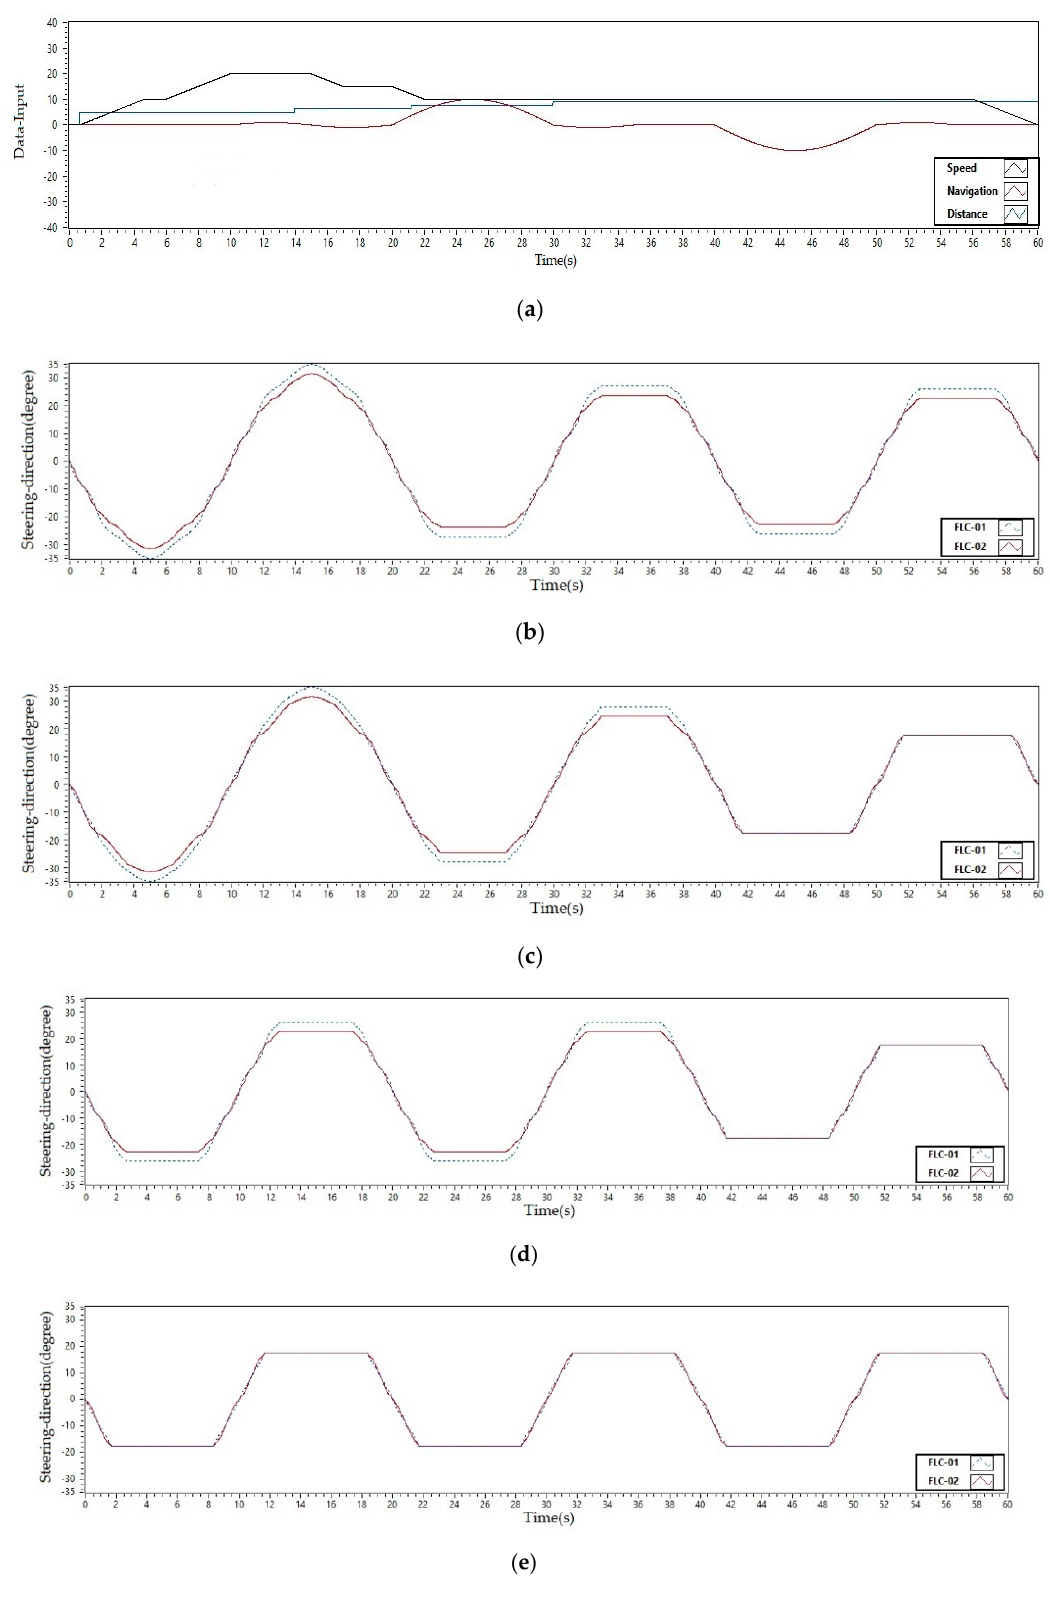
Figure 6. ( a ) Input of system; ( b ) system output at speed 10 km/h; ( c ) system output at speed 20 km/h; ( d ) system output at speed 30 km/h; and ( e ) system output at speed 40 km/h. According to the previous description and Figure 6d, the steering angle control value at 30 speeds for short and medium distances was similar. Type-1 FLC had an angle of 26.25 degrees, while type-2 FLC was at 22.750 degrees. The steering angle of type-2 FLC was smaller than that of type-1 FLC. This indicates that type-2 FLC had better control at high speeds. Furthermore, the shape of the graphic response was also smoother. Mean- while, with a long-distance input of 10 meters, both showed the same steering angle re- sults. At a high speed (according to city car specifications) of 40 km/h and at a distance of 3.5 meters, both type-1 and type-2 FLC achieved a maximum steering angle of –17.5 de- grees in 1.68 seconds to 8.32 seconds. The direction shown was to the left because it was negative. Meanwhile, at 11.68 seconds to 18.32 seconds, the steering angle showed a value of 17.5 degrees in positive numbers, indicating the right direction. The same thing happened when the obstacle distance was increased to seven meters. Both the right and left steering directions still showed a value of 17.5 degrees in response to the sinusoidal navigation input. The steering angle of the autonomous vehicle remained at 17.5 degrees both to the right and to the left for a 10-meter distance. The control results are presented in Figure 6e . The steering system produces a small steering angle at high speeds, according to the analysis. This prevents uncontrollable movements in the vehicle caused by a large steering angle when going fast. According to Figure 6e, the type-2 FLC (dotted line) output was smoother than the type-1 FLC output (dashed line). This indicates that the type-2 FLC had better high-speed control . 5. Experimental and Discussion Following the simulation, we applied it to the Sultan Agung Autonomous Vehicle (SAAV). The SAAV is an electric car designed by H-Molex, with dimensions of 160 cm long and 96 cm wide. Figure 7 shows a SAAV equipped with an autonomous system and steering motor. A modified Daihatsu Xenia 2012 steering system, consisting of an EPS (electric power steering) motor and its column, was used as the driving force for the steer- ing wheel. The motor has a specification of 2000 rpm 12 volts. The system steering uses a